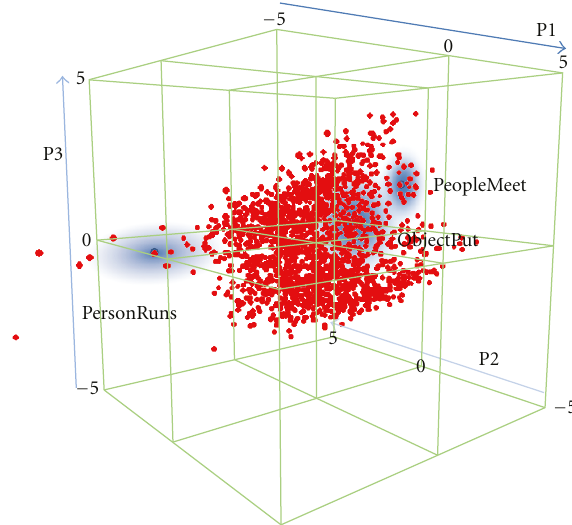
Figure 17: Scatter diagram of the trajectory feature